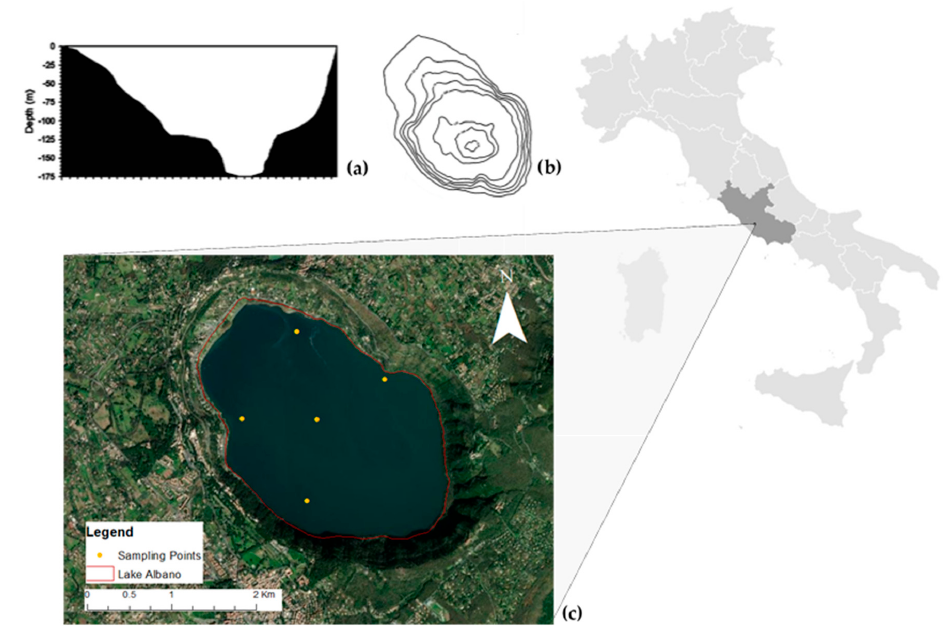
Figure 1. ( a ) Cross-section of Lake Albano’s profile and ( b ) bathymetry map [22]; ( c ) True color composite (red, green and blue, RGB) image of Lake Albano with sampling points’ location ( c ); the red line indicates the perimeter of the lake before the water level reduction.